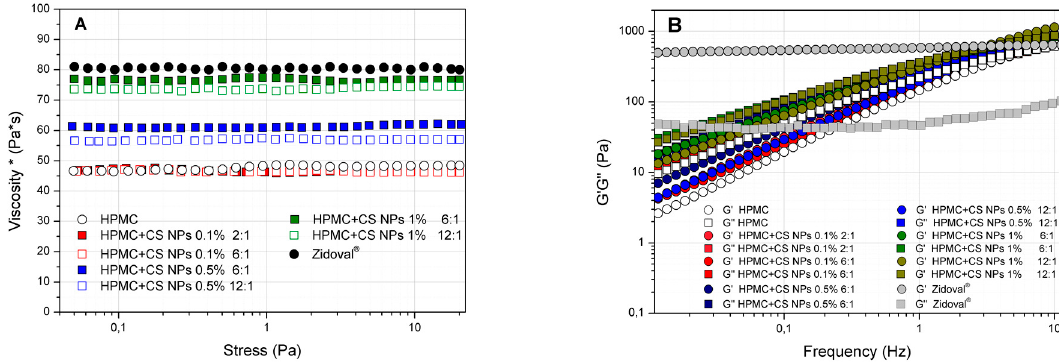
Figure 3. Rheological results of stress sweep ( A ) and frequency sweep ( B ) tests obtained from hydroxypropyl methylcellulose (HPMC)/Chitosan NPs hydrogels at 37 °C.